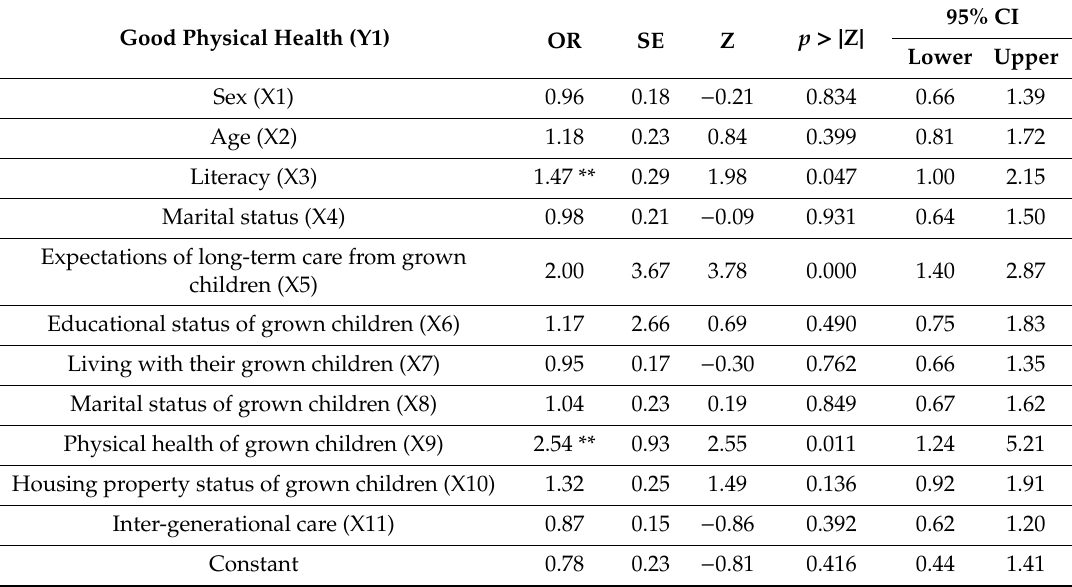
Table 5. Logistic regression results on the physical